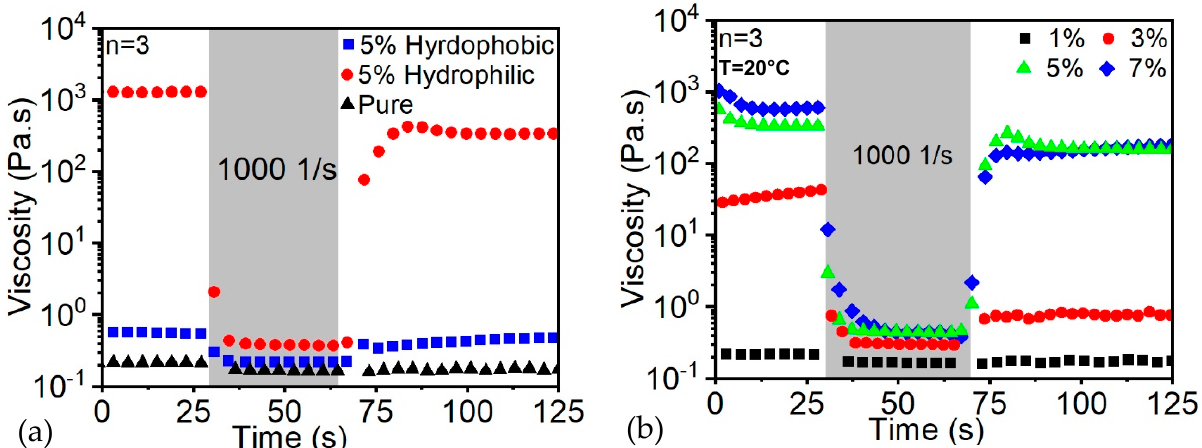
Figure 4. The effects of ( a ) two types of FS; ( b ) FS amount on ink thixotropic behavior.